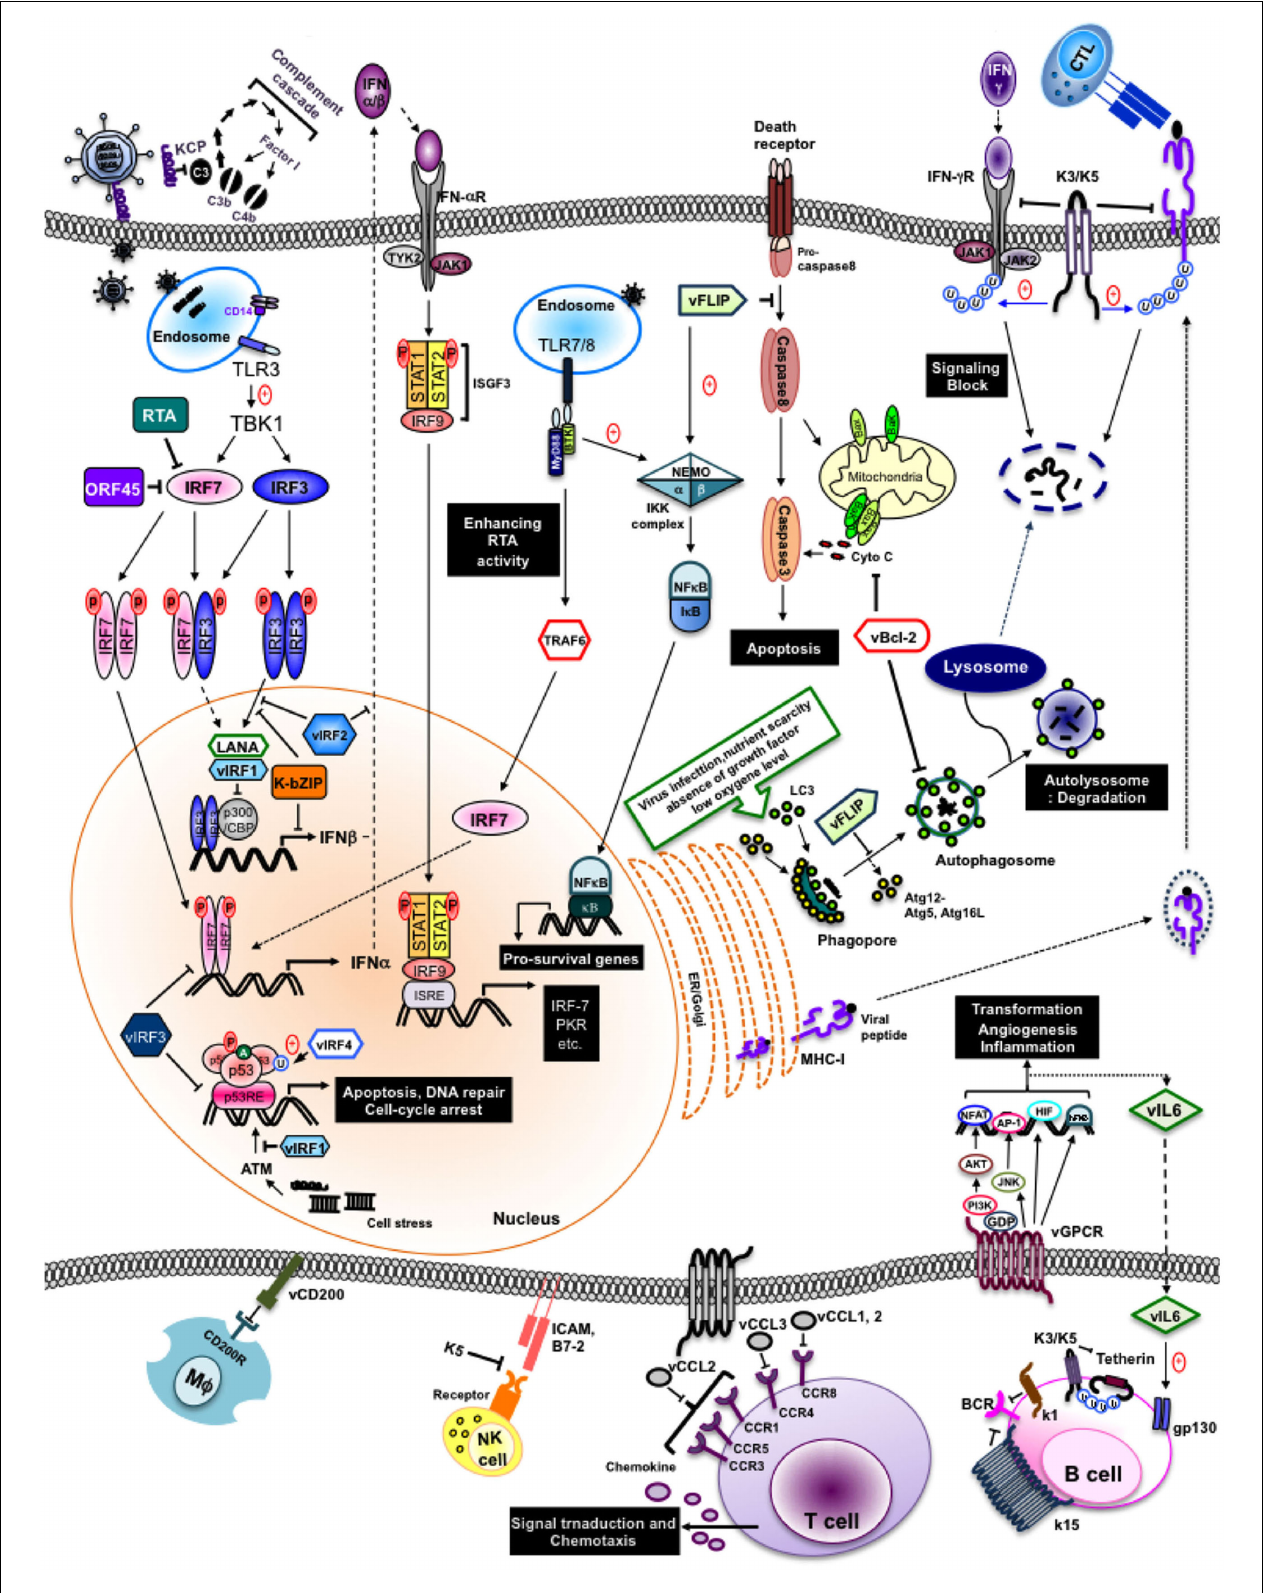
FIGURE 1 | Evasion of immune responses by individual KSHV products. Individual KSHV products are shown to circumvent immune response, both innate and adapt, during their life cycle.